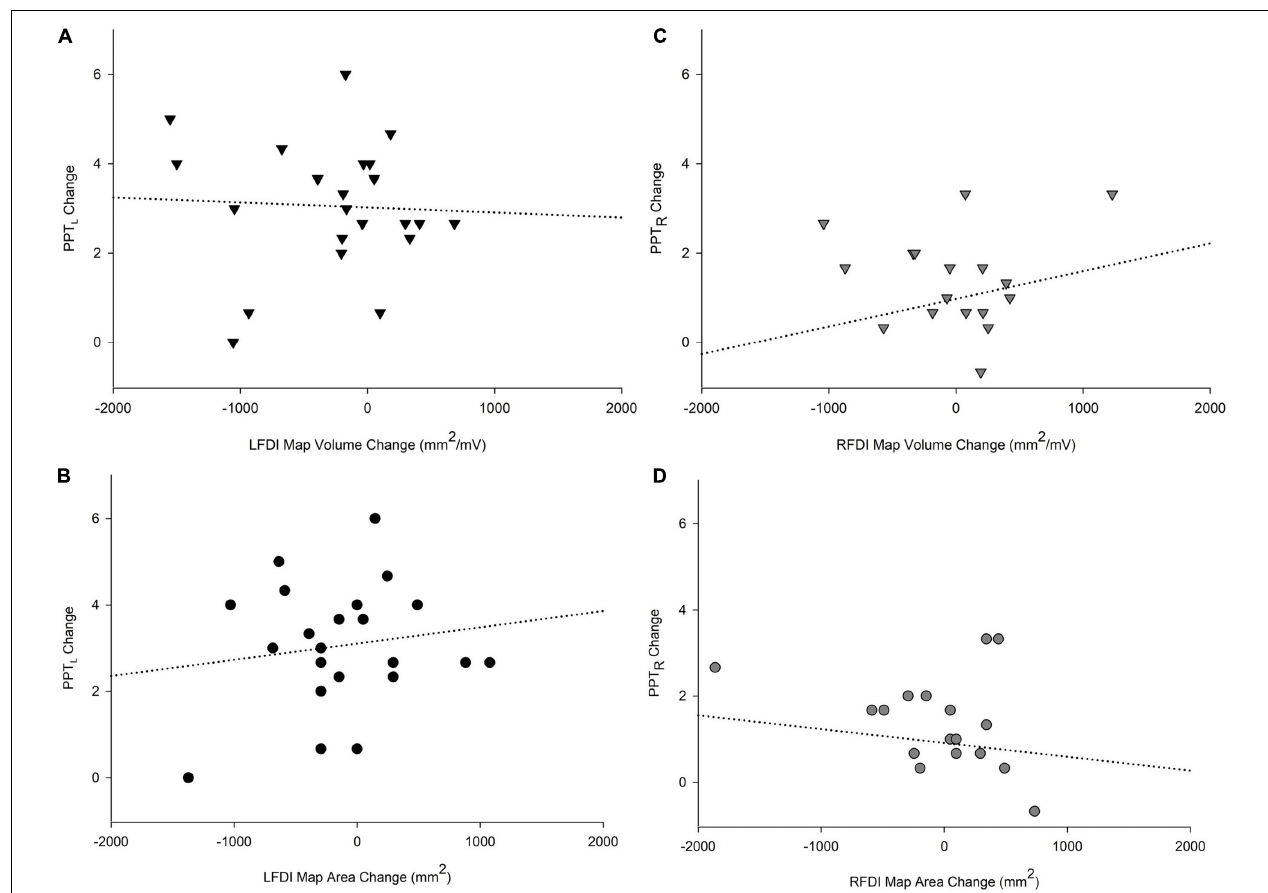
FIGURE 6 | Relationships of PPT motor performance with map volume (mm 2 /mV) and area (mm 2 ). Change in PPT L scores with LFDI map volume (A) and area (B) . Change in PPT R scores with RFDI map volume (C) and area (D) . Linear regression showed no significant relationship between change in FDI map volume and area with change in PPT scores between the pre and post in either hand. LFDI = left-hand first dorsal interosseous muscle; RFDI = right-hand first dorsal interosseous muscle; PPT = change in number of pegs from pre-to-post; PPT L = Left-hand; PPT R =